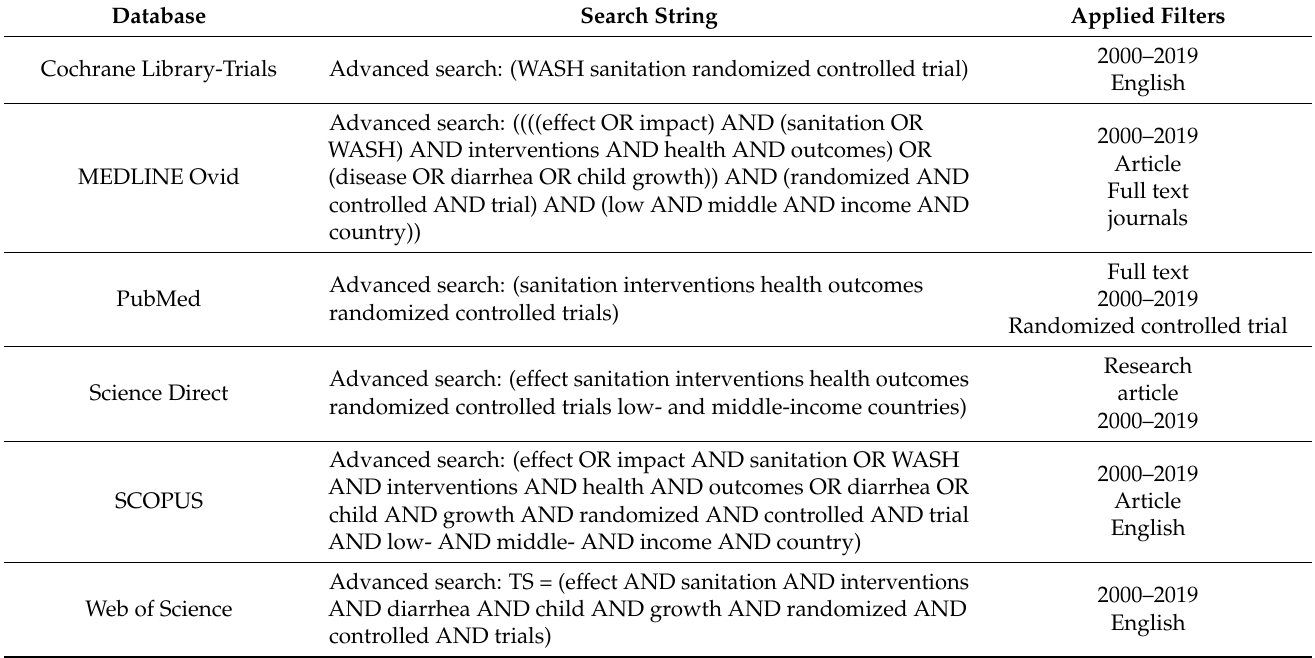
Table 1. Literature search